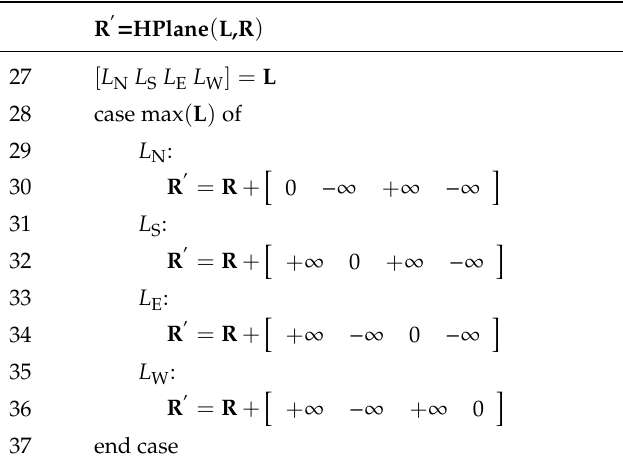
Figure 4. Half-plane produced by node 3 in node 1. Table 4. Half-plane VO.